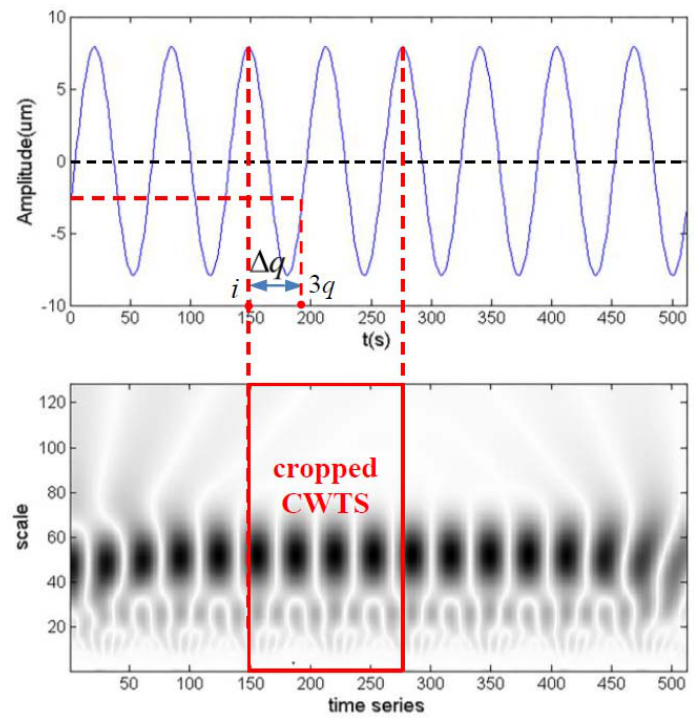
Figure 4. CWTS cropping of the signal in Figure 2, above: fundamental rotating frequency waveform of the signal, below: the CWTS of the signal.